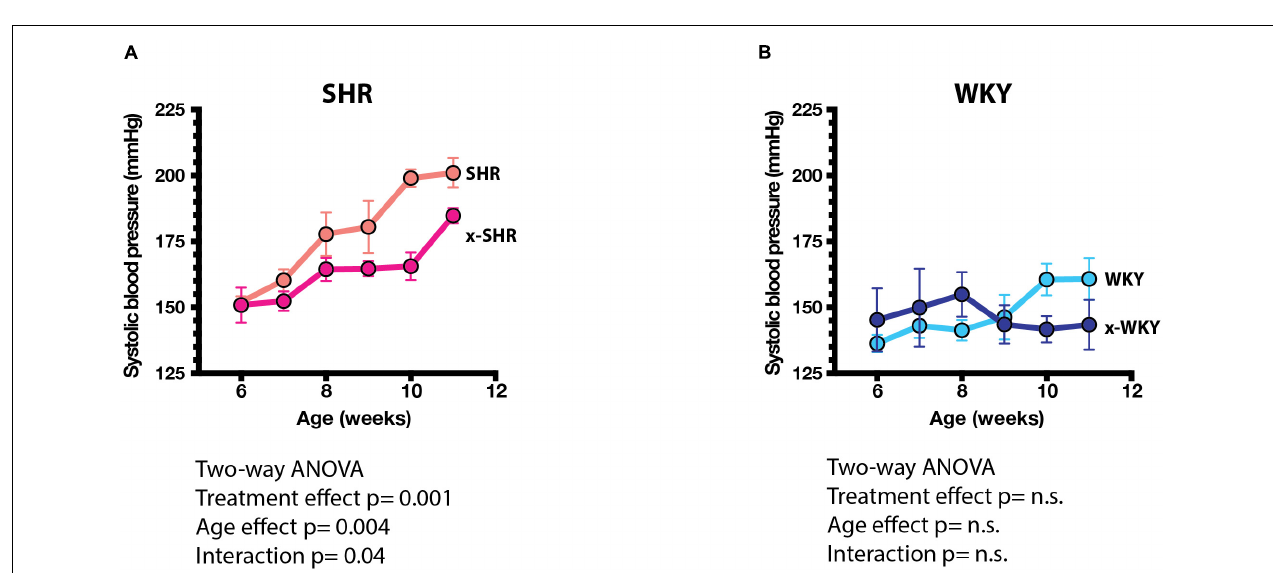
FIGURE 2 | (A) Differences in neonatal major phyla between self-fostered ( n = 3 each) and cross-fostered x-WKY and x-SHR ( n = 6 each). (B) Changes in major ASV of the gut microbiota between 1-week old self-fostered WKY and SHR ( n = 3 each) and between 1-week old cross-fostered x-WKY and x-SHR ( n = 6 each). Asterisks denote statistically significant difference ( ∗ P < 0.05, ∗∗ P < 0.01, ∗∗∗ P < 0.001, **** P ≤ 0.0001, one-way ANOVA with Sidak’s post hoc multiple comparison test), n.s. denotes not statistically significant.